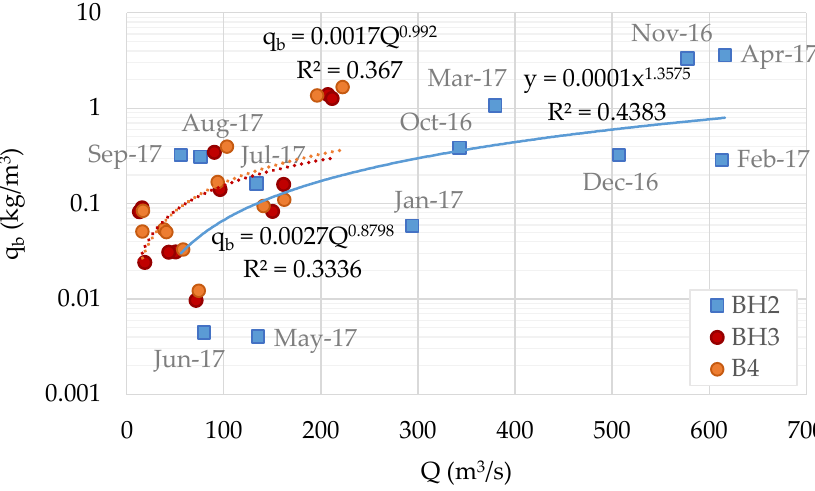
Figure 7. Sediment transport rate and flow discharge relation.